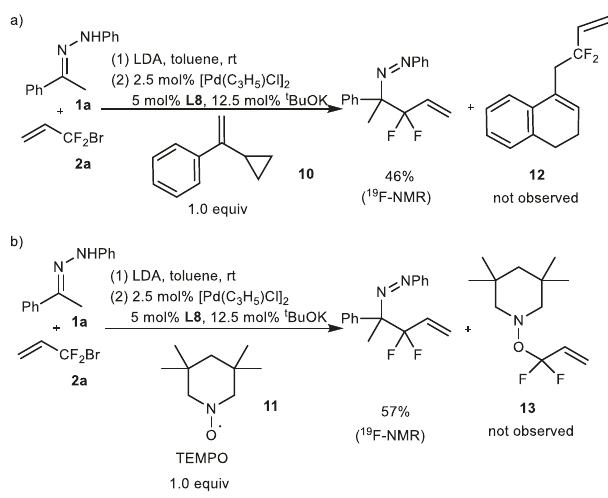
Fig. 8 Control experiments. a Palladium-catalyzed reaction of hydrazone 1a with BDFP 2 in the presence of radical clock 10 . b Pd-Catalyzed reaction of hydrazone 1a with BDFP 2 in the presence of TEMPO 11